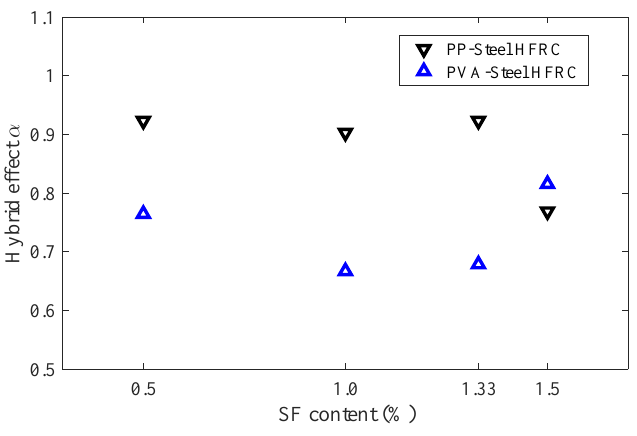
Figure 16. Fiber-hybrid effect for